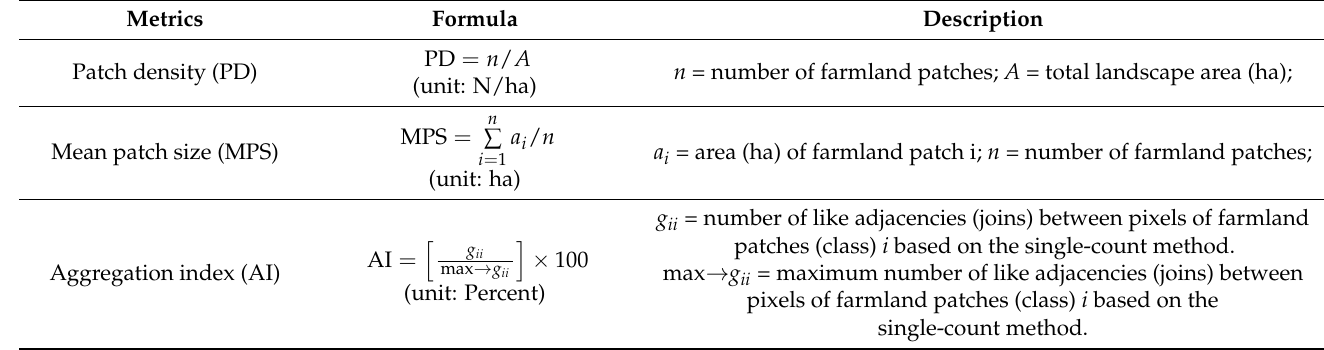
Table 1. Description of the three indicators to measure farmland landscape patterns. Metrics Formula Description PD = n / Patch density (PD)